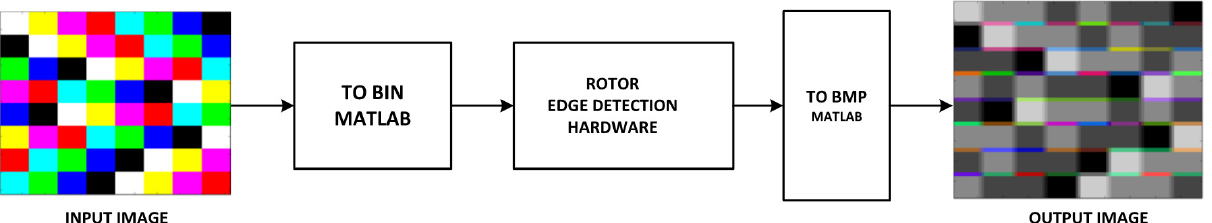
Figure 5. Offline processing with the GA Coprocessor